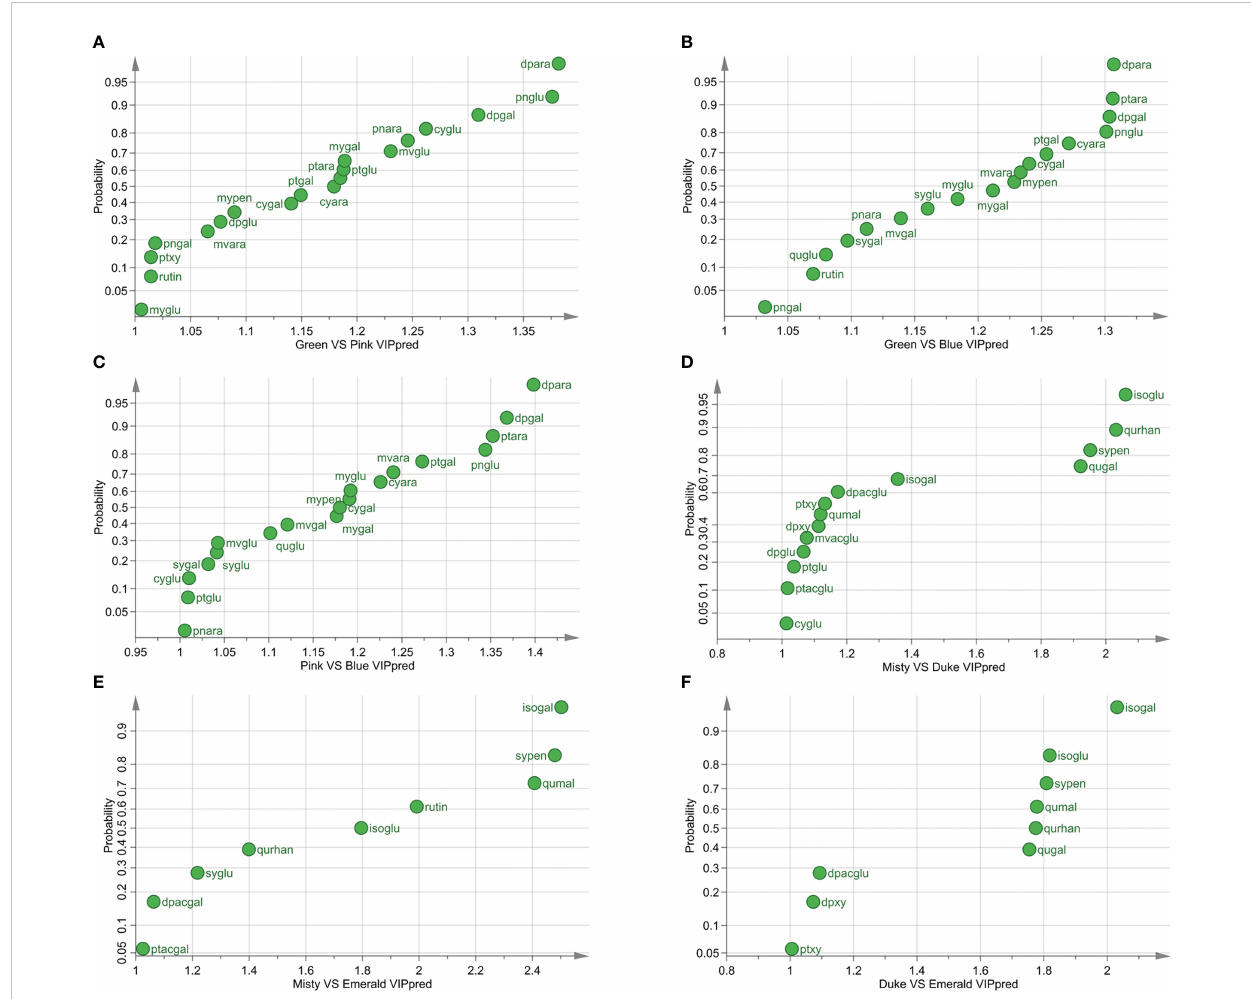
FIGURE 2 Different metabolites of three varieties at different developmental stages. (A) Differential metabolites of three blueberry varieties at the green and pink stages (VIP > 1). (B) Differential metabolites of three blueberry varieties at the green and blue stages (VIP > 1). (C) Differential metabolites of three blueberry varieties at the pink and blue stages (VIP > 1). (D) Differential metabolites of Misty and Duke in three developmental stages (VIP > 1). (E) Differential metabolites of Misty and Emerald in three developmental stages (VIP > 1). (F) Differential metabolites of Duke and Emerald in three developmental stages (VIP > 1). VIPpred > 1, predictive variable importance for the projection larger than